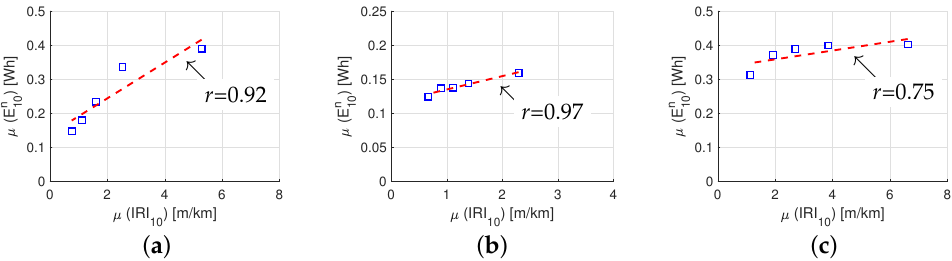
Figure 9. Relationship between road roughness and normalized energy for ( a ) group no. 1: highway and urban road, ( b ) group no. 2: highway road, and ( c ) group no. 3: urban